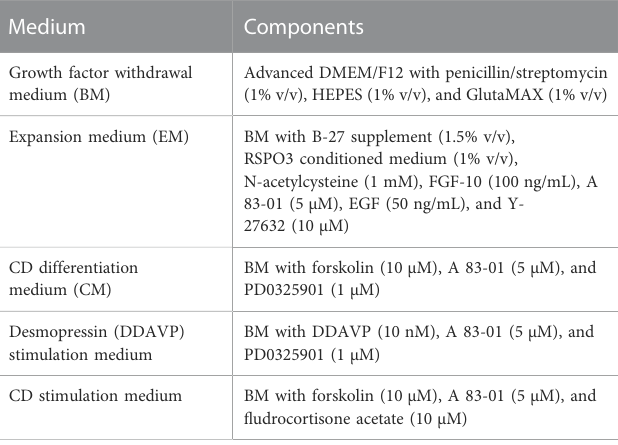
TABLE 1 Composition of the media used.